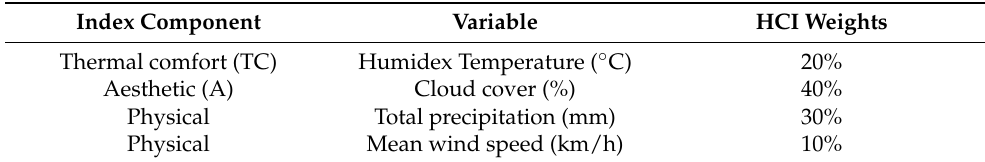
Table A2. Weather components and